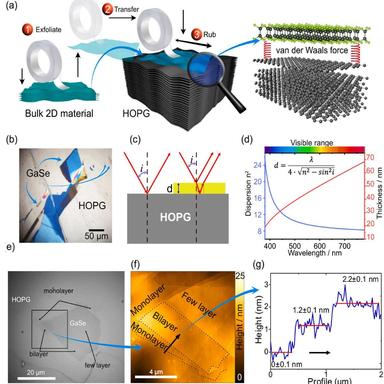
a) Deposition of 2D materials on HOPG, b) Optical image of GaSe layers with different thicknesses on HOPG. c) Optical interference schematics showing the optical paths in the system of 2D materials on HOPG. d) A plot of refractive index dispersion dependence on wavelength and GaSe thickness according to the interference maxima wavelength for zero order. e) Optical image of the region of interest with a 100x objective shown in brown color scheme for improved contrast. f) AFM topography of GaSe. g) Cross-sect